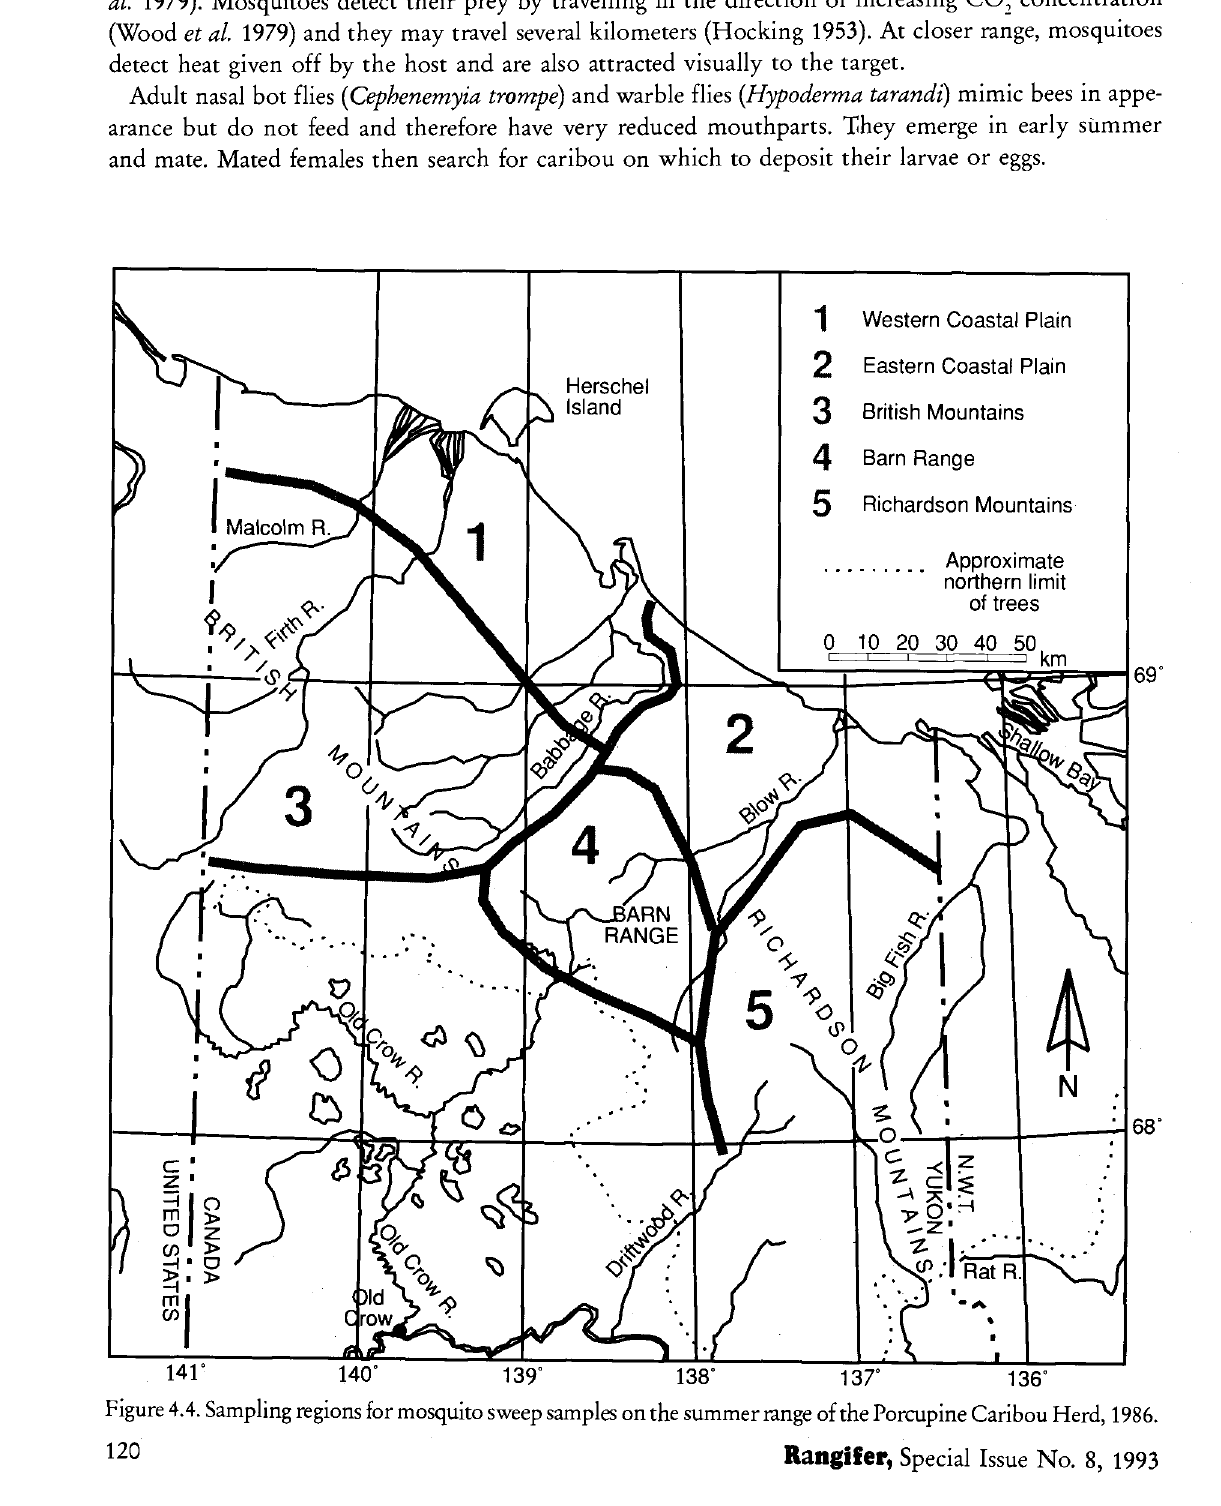
Figure 4.4. Sampling regions for mosquito sweep samples on the summer range of the Porcupine Caribou Herd,